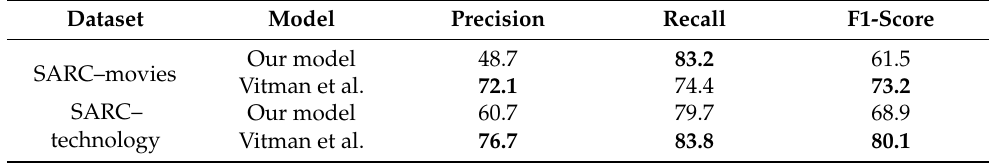
Table 4. SARC benchmarking. Bold highlights the best result for the specific metric (column). Dataset Model